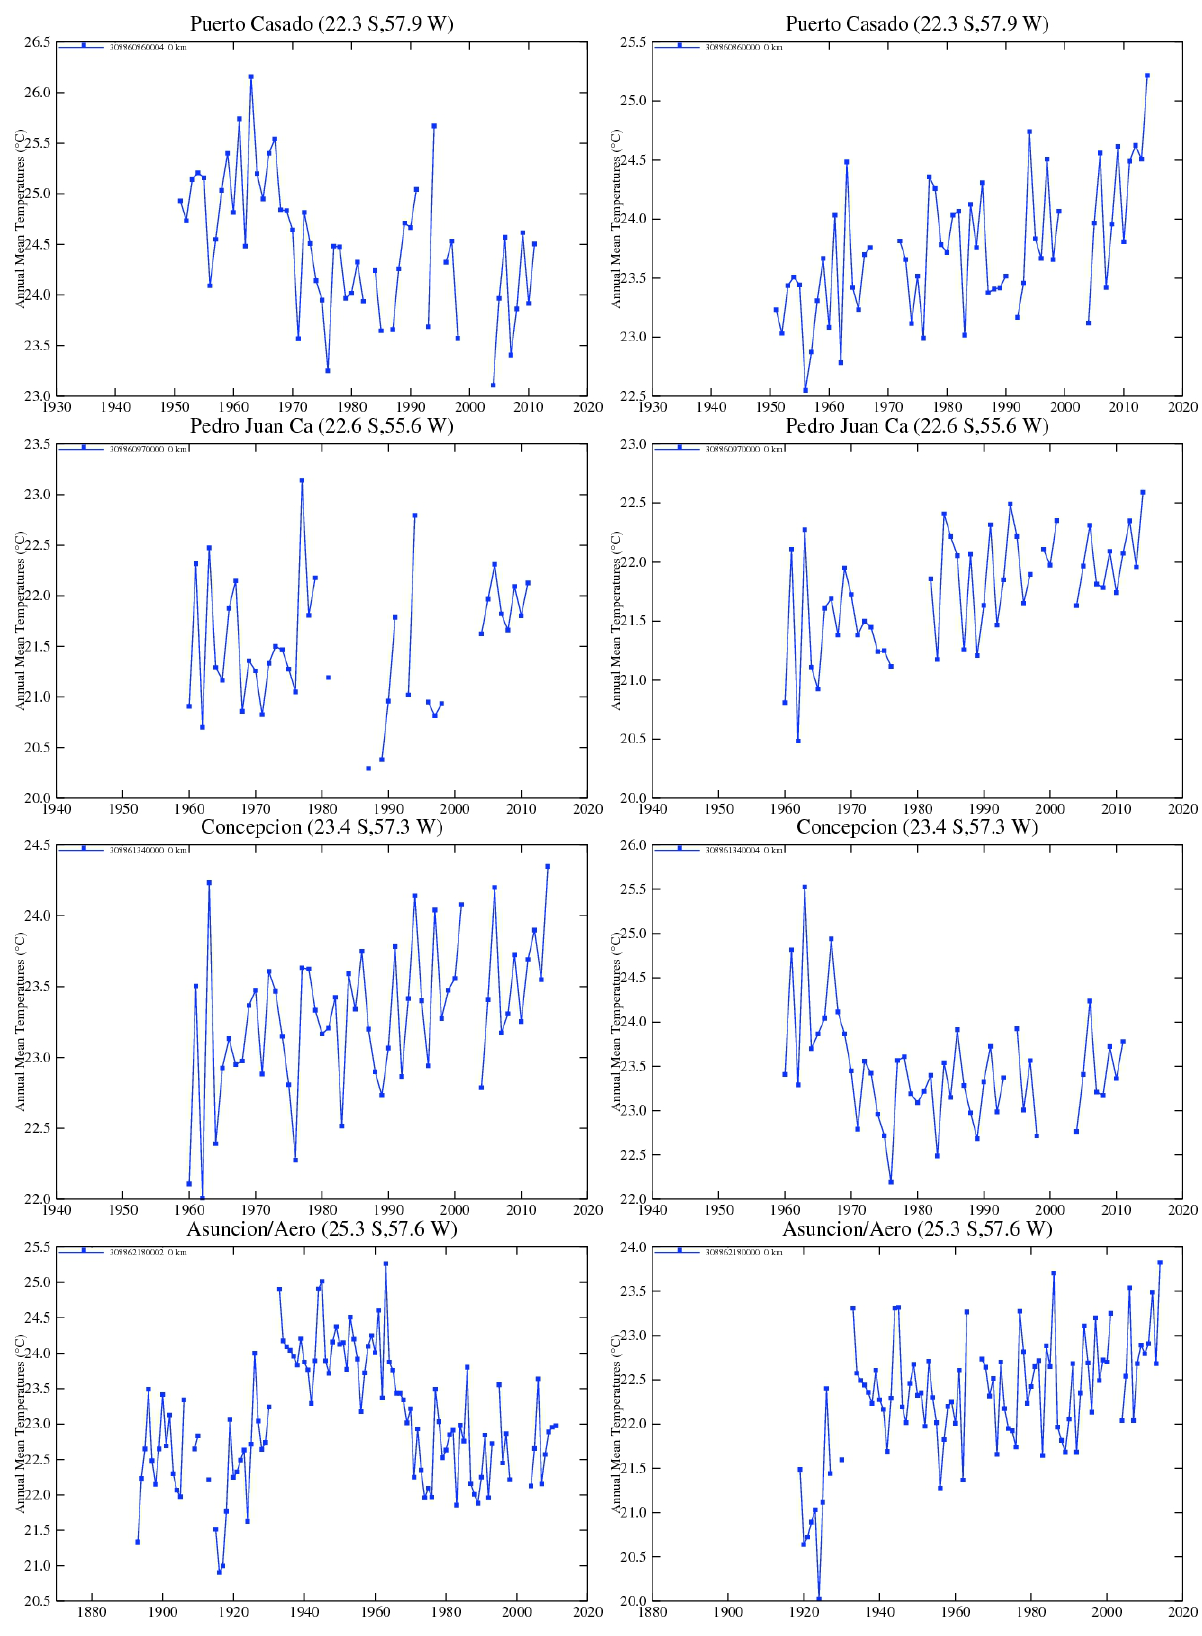
Fig. A.1: (Continued) GISS v2 vs. v3 temperature records for all the stations of Paraguay. In all cases coolings or no warmings have been transformed in significant warmings claiming impossible homogenization with previously massaged data. GISS v2 data on the left, GISS v3 data on the